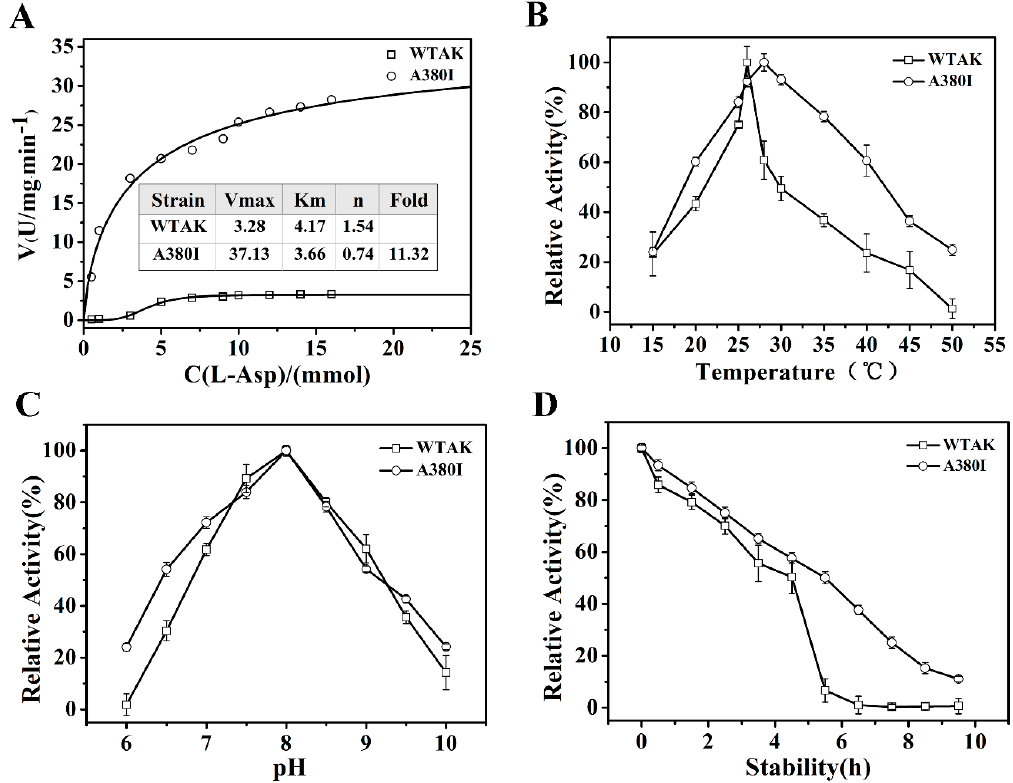
Figure 3. Dynamic analysis and enzymatic properties. ( A ) Dynamic analysis; open circle represents A380I; open square represents WT-AK, the same below. ( B ) The optimal temperature. ( C ) The optimal pH. ( D ) Thermal stability.